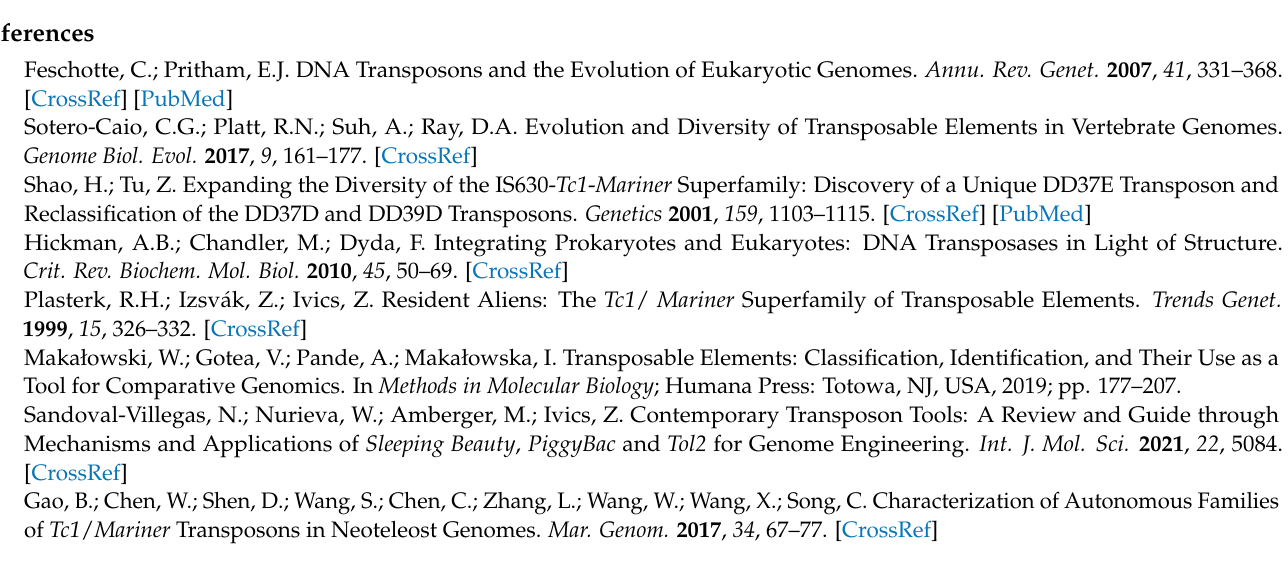
Table S1: Taxonomic distribution of SB and ZB ; Supplementary Table S2: Genomic coordinate of SB and ZB ; Supplementary Table S3: Taxonomic distribution of ZB and SB elements in the Actinopterygii; Supplementary Table S4: Species containing several transposons; Supplementary Tables S5 and S6: The genetic distances between cytoplasmic ribosomal proteins transposons in species;